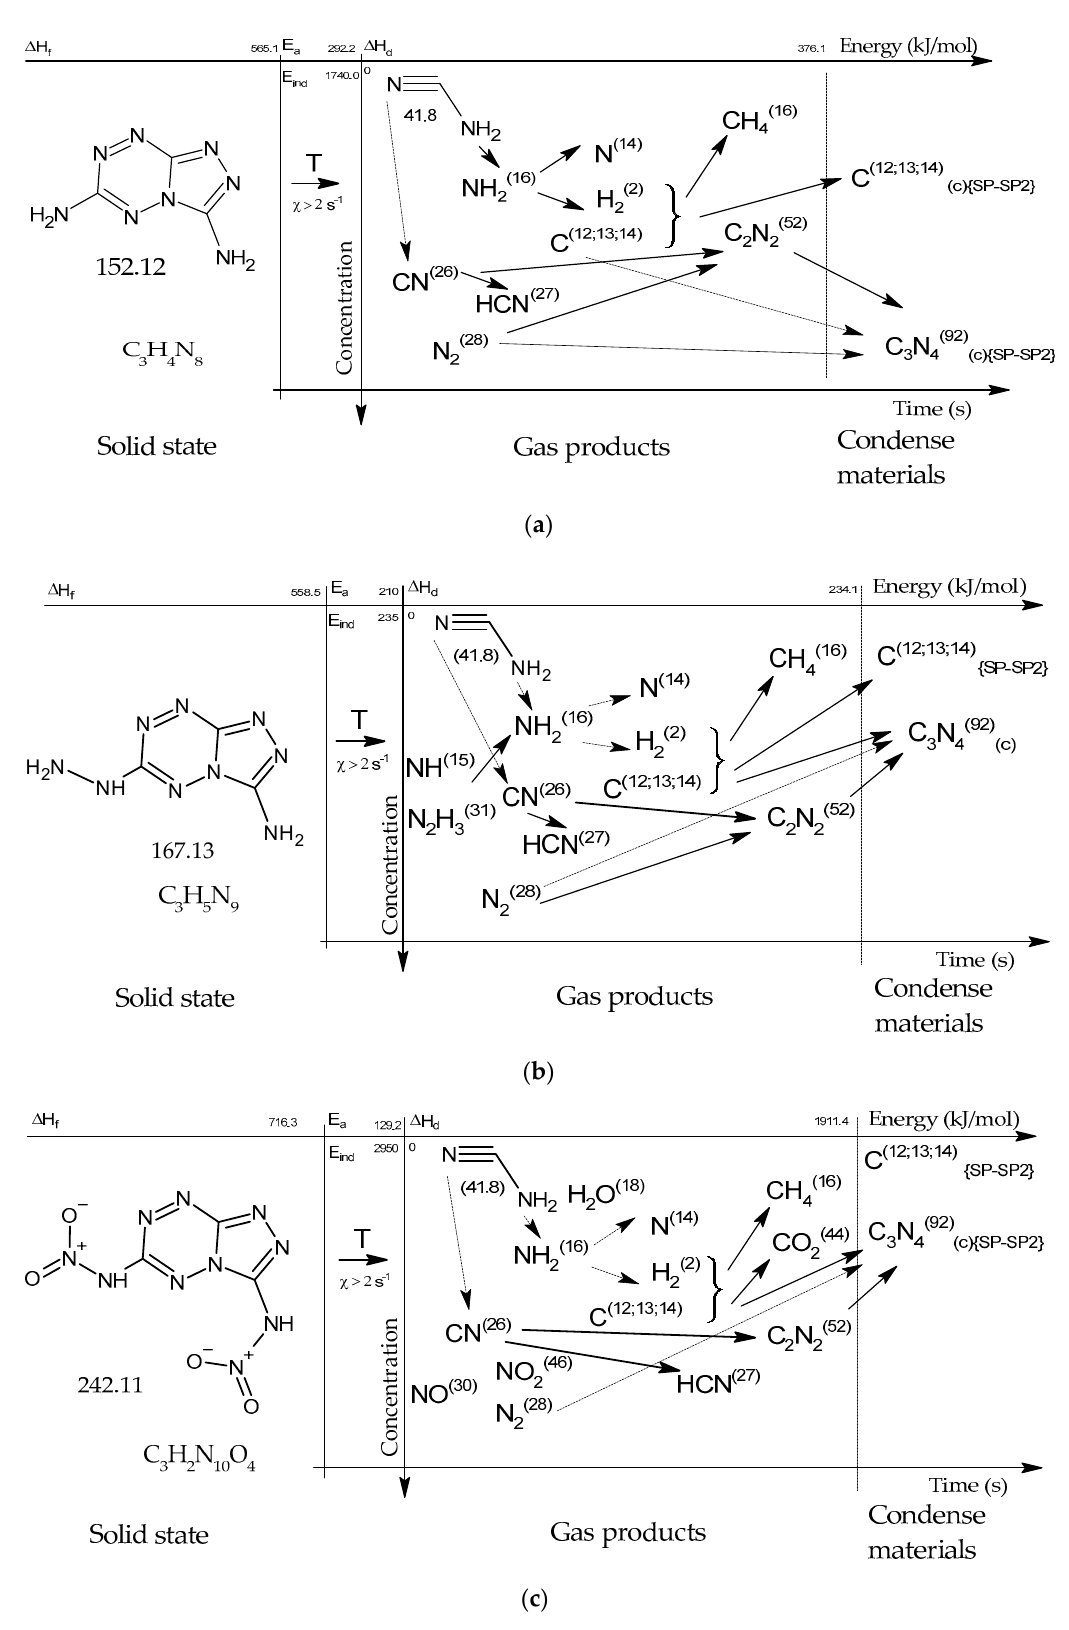
Figure 15. Concentration-energy diagrams of thermal decomposition reactions of [1,2,4]triazolo[4,3- b ][1,2,4,5]tetrazine derivatives: TTDA ( a ), TTGA ( b ), DNTT ( c ) at heating rates of more than 100 min − 1 .